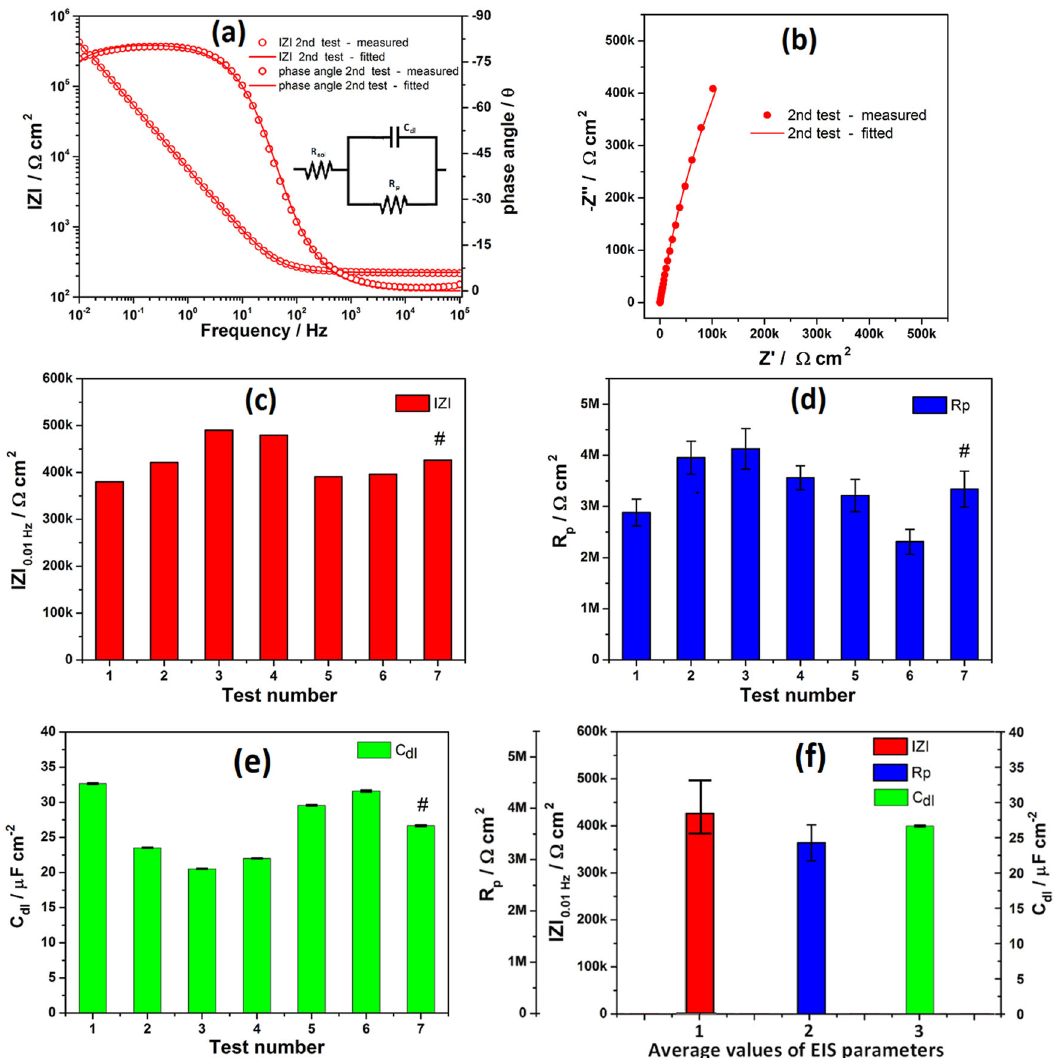
Fig. 3 EIS spectra of CFRP at OCP. Measured and fi tted impedance spectra, and fi tted parameters for each of the hextuple EIS tests on CFRP in 50 mM NaCl after 1 h immersion at OCP, a representative Bode plot (log impedance modulus and phase angle, inset is equivalent circuit used to fi t impedance spectra), b representative Nyquist plot, c measured low-frequency impedance (at IZI 0.01 Hz ), d fi tted polarization resistance, e calculated double-layer capacitance (Test number 7 and # denote the mean values from six measurements), and f mean values of EIS parameters (from hextuple